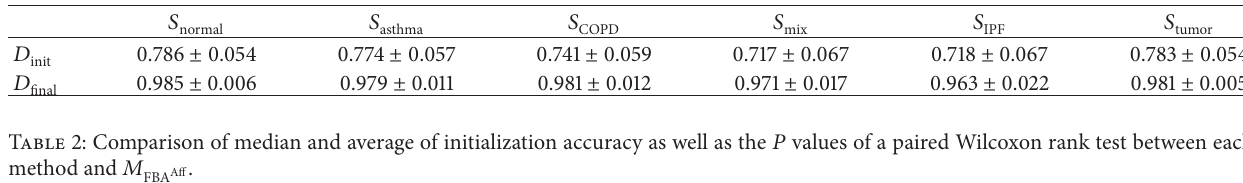
Table 1: Average initialization and final segmentation accuracy obtained by 𝑀